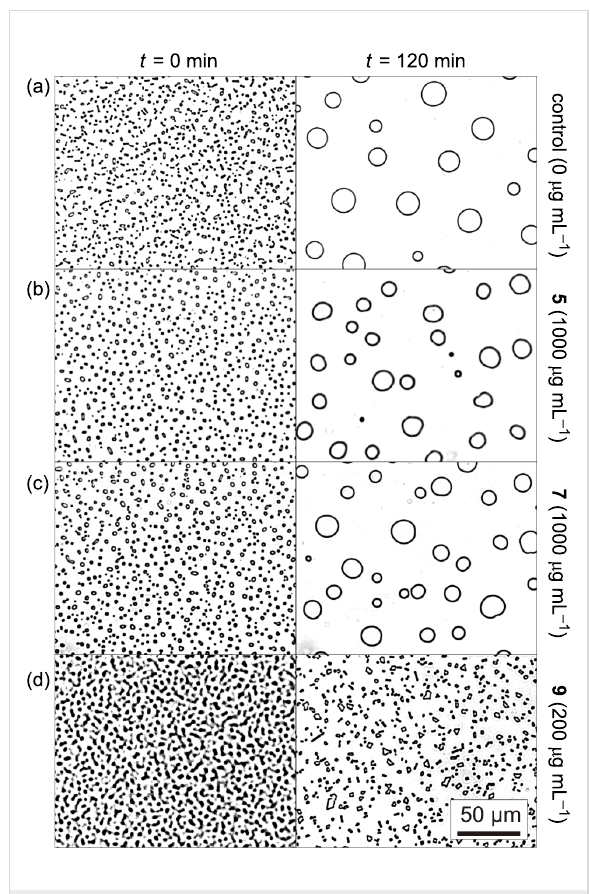
Figure 5: Optical microphotographs taken after 0 and 120 min during the recrystallization process of polycrystalline ice samples at − 8 °C formed in aqueous 45 wt % sucrose solutions. (a) Negative control solution without peptides. (b) Peptide 5 ( c 1000 µg mL − 1 ). (c) Peptide 7 ( c 1000 µg mL − 1 ). (d) Positive control solution containing 200 µg mL − 1 of the ice recrystallization inhibiting peptide 9 ([AAT(GalNAc)] 4 AA). The pictures were contrast-enhanced for better